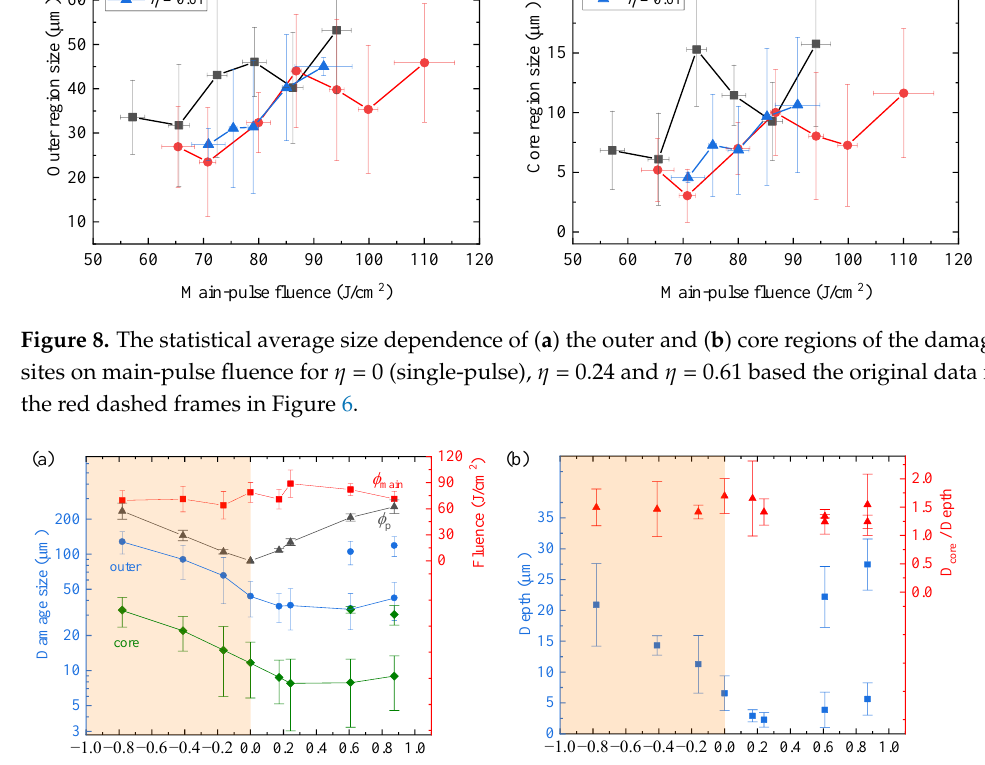
Figure 9. ( a ) Average damage size of the outer and core regions near the threshold as functions of the shape factor η at the 20 ns delay. The fluences for the main pulse and the pre- or post-pulse are also shown as the red squares and black triangles to reveal their roles in the modulation of the damage sizes. ( b ) Average damage depth (blue squares) and ratio of the core diameter to depth (red triangles) near the threshold as functions of the shape factor η at the 20 ns delay.